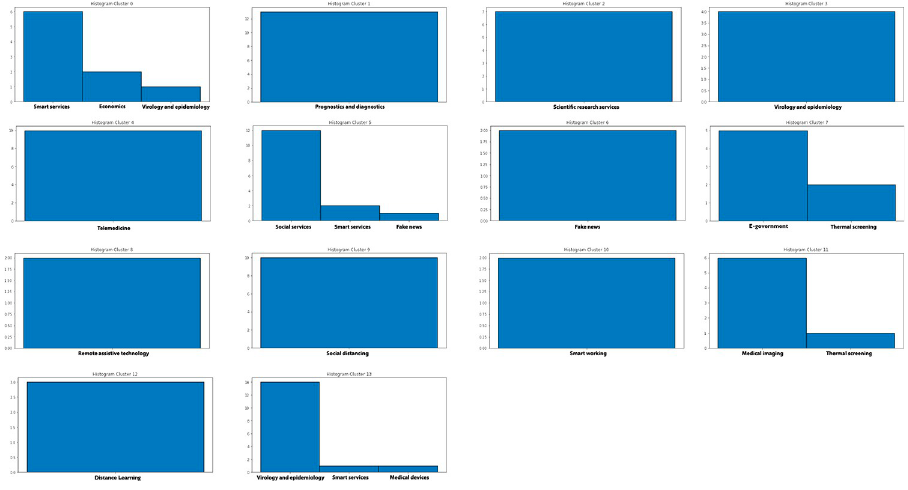
Fig 21. Details of clusters for CONF-1.